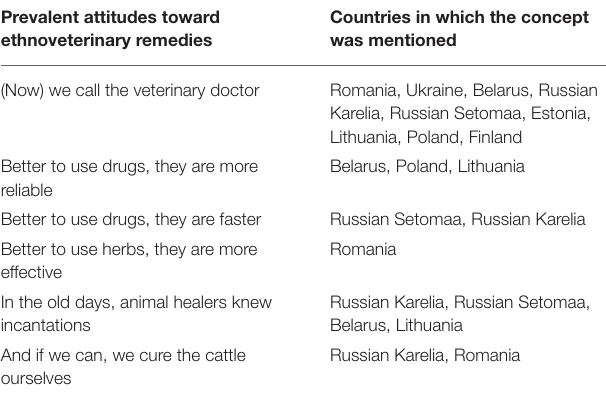
TABLE 4 | Prevalent attitudes toward ethnoveterinary